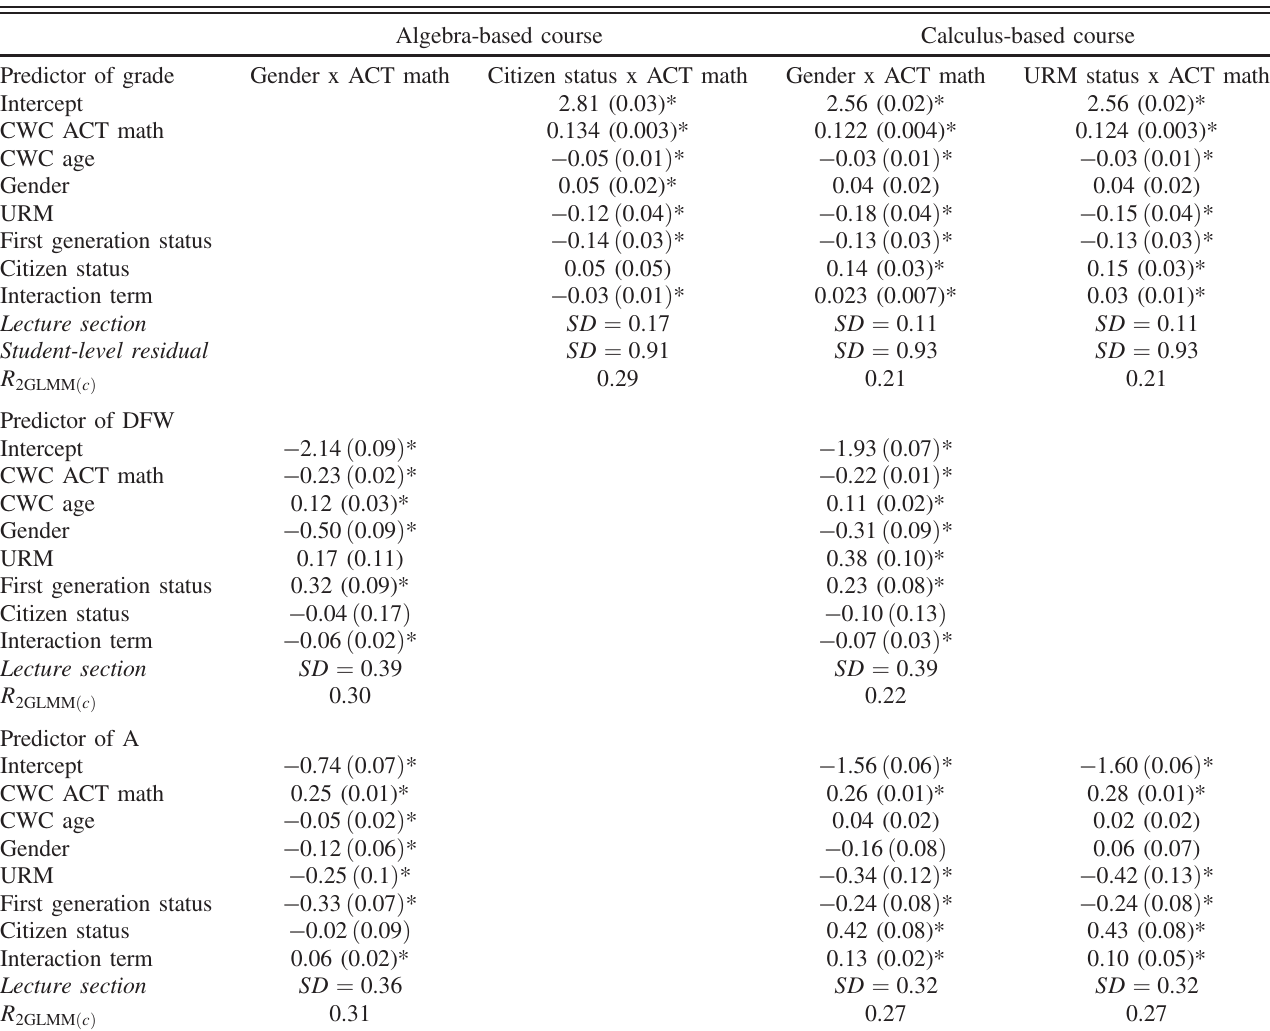
TABLE III. Multilevel model results with significant interaction terms. Nonstandardized fixed effects estimates are reported with standard errors given in parentheses. A significance of p < 0 . 05 is indicated by *. The random effect of lecture section and its standard deviation are reported in